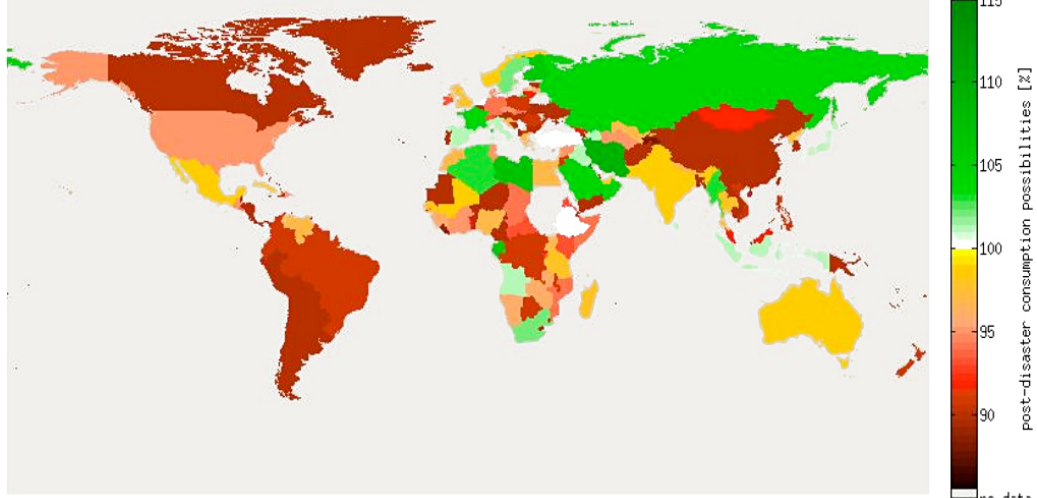
Figure 3. Effects of scenario 1, a Quebec 1989-like event centered over the Americas. Globally, the storm would reduce total consumption possibilities by 3.9% though the effect is uneven: it is most severe in countries directly affected and their economic partners, while other countries (e.g., Russia, Saudi Arabia, France, and Egypt) may gain consumption possibilities in the post-disaster